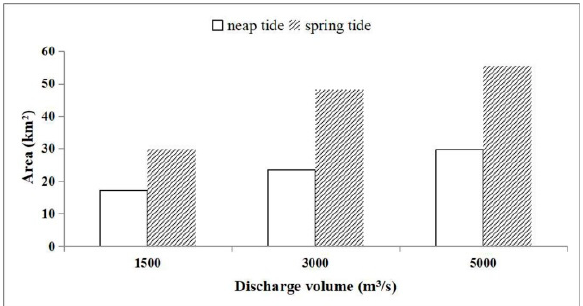
Figure 11. Salinity interval area suitable for phytoplankton growth under di ff erent scheduling